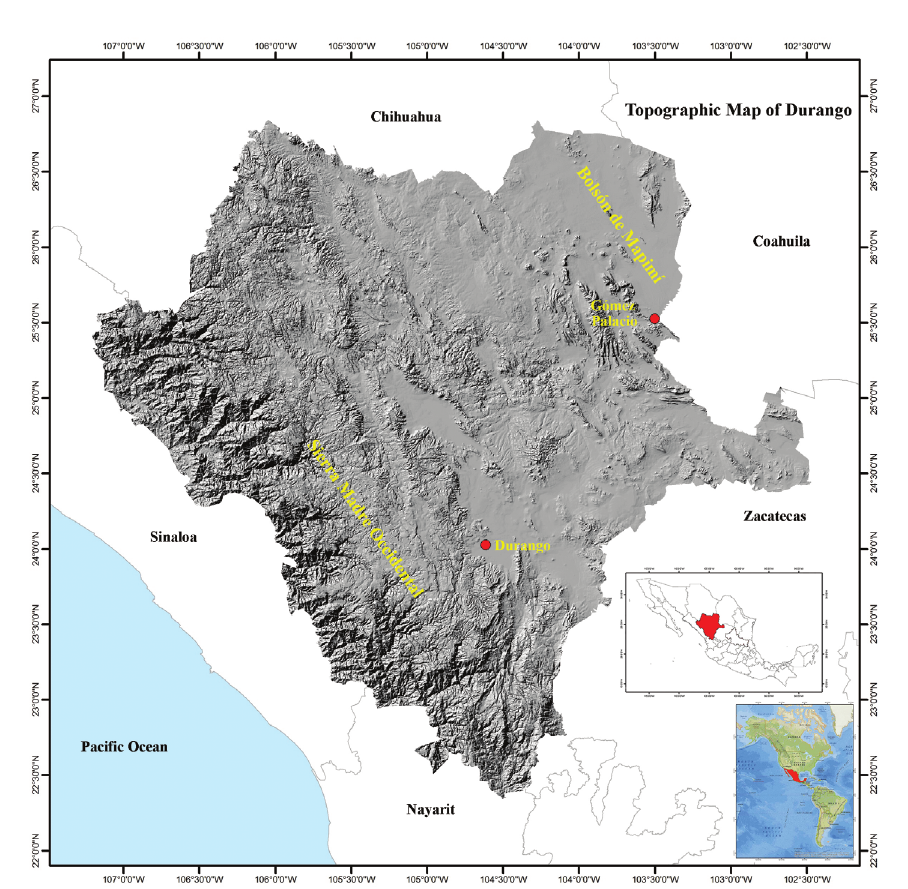
Figure 1. Topographical map of the state of Durango, Mexico (INEGI 2001). Map of America modified from http://www.gifex.com/fullsize/2009-09-17-3/Mapa-de-Amrica.html; Map of Mexico with the state of Durango in red modified from Comisión Nacional para el Conocimiento y Uso de la Biodiversidad